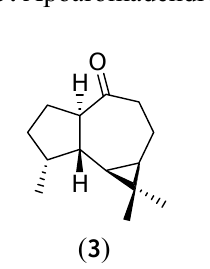
Figure 3: Apoaromadendrone ( 3 )